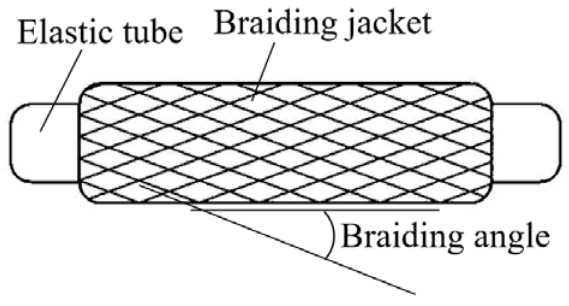
Figure 1. Schematic of McKibben-type pneumatic artificial muscle.